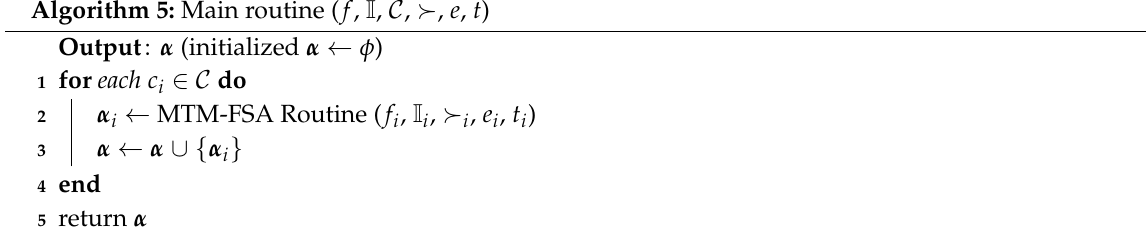
Algorithm 5: Main routine ( f , I ,